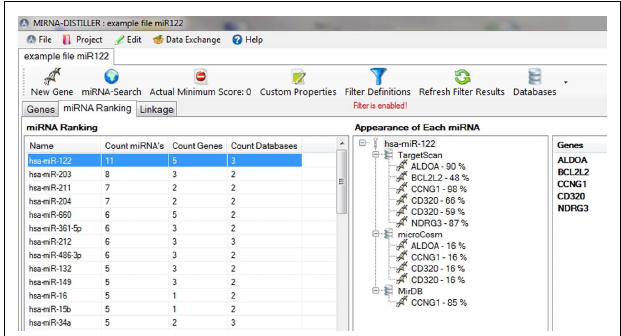
FIGURE 4 | Illustration of the linkage graph. The Linkage tab automatically calculates the fraction of concordant miRNAs predicted for any two genes and displays them as a graphical matrix.This function facilitates identification of potentially co-regulated genes.The calculation of this graph takes filter settings automatically into account.